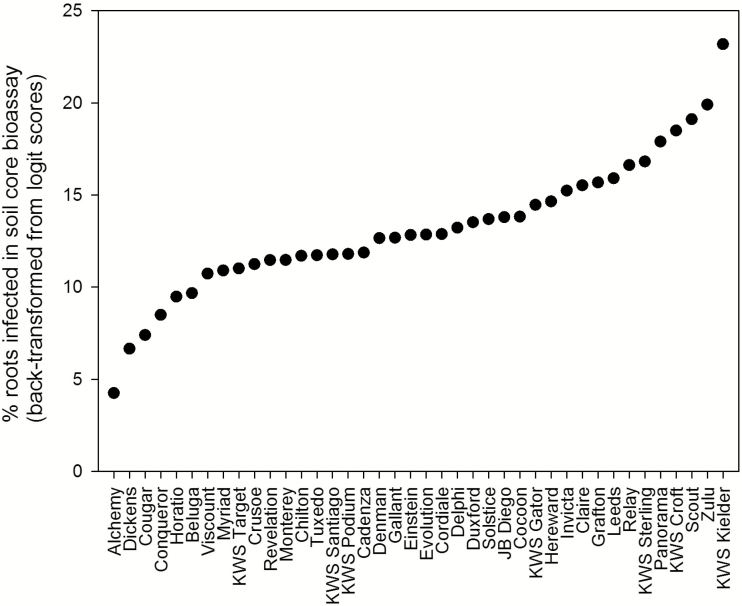
Percentage of roots colonized with Gaeumannomyces hyphopodioides (back-transformed means of the logits) when baited with the winter wheat cultivar Hereward in the soil core bioassay. Combined analysis of data pooled across the two years (χ2 probability <0.001, SED (logit scale)=0.171, Wald statistic=637.76). See Supplementary Table S5 for data on logit scale.